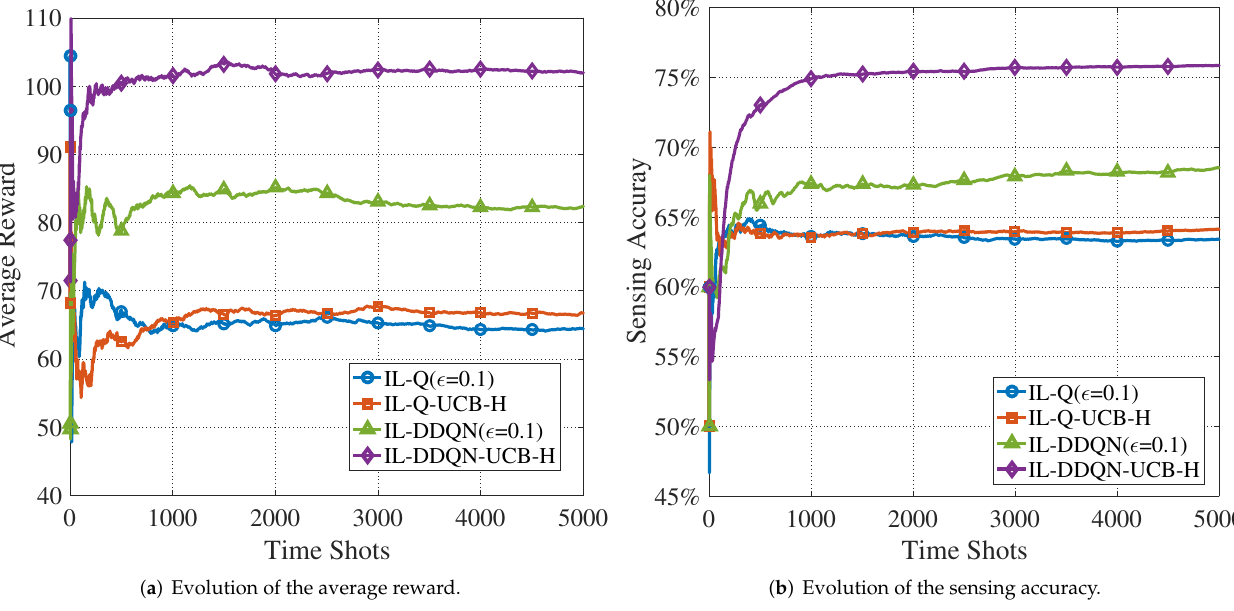
Figure 7. Evolution of the average reward and the sensing accuracy with training ( N = 6, M = 5). Figure 6b evaluates the sensing accuracy of the four algorithms with N = 4, M =